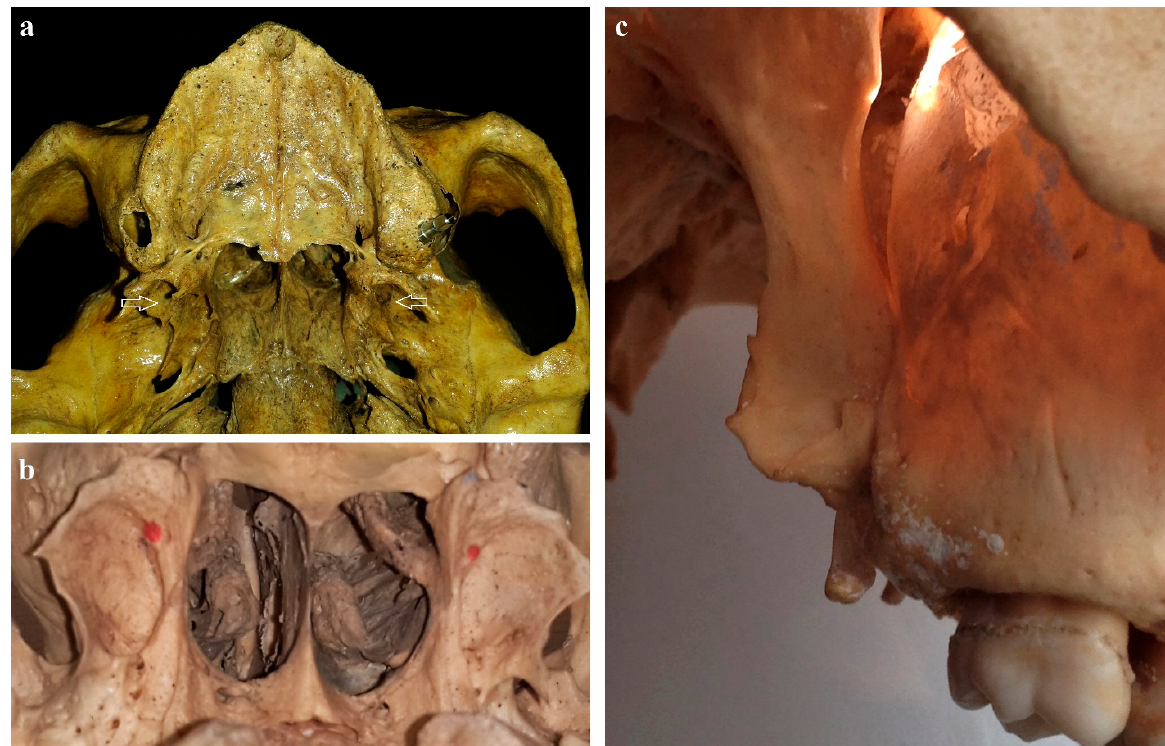
Figure 1. View from distal towards both processus pterygoidei and into the nasal cavity ( a , b ). White arrows indicate the junction zone of the pterygoid process, maxillary tuberosity and pyramidal process ( a ). Red points mark ideal penetration points for the apex of the implants ( b ). This case shows a pronounced atrophy of the distal maxilla (centrifugal atrophy) ( b ). View of lateral distal maxilla and adjacent processus pterygoidei of the sphenoid bone ( c ).